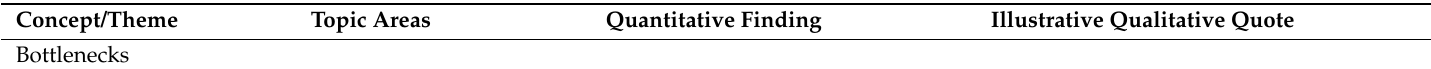
Table 3. Triangulation of quantitative and qualitative